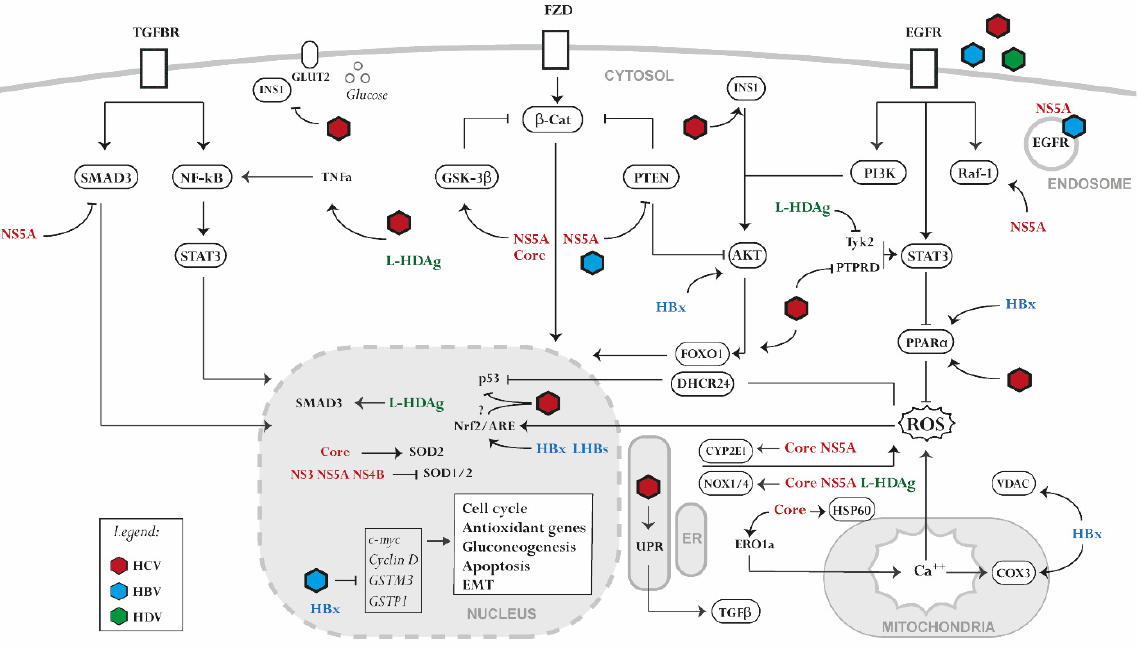
Figure 1. Signaling pathways perturbed by hepatotropic viral proteins. HCV, HBV, and HDV alter liver homeostasis by disrupting several signaling processes associated with (1) the generation of oxidative stress and the dysregulation of the antioxidant system, (2) the alteration of a pro- inflammatory signaling, (3) the hijacking of glucose and lipid metabolism, (4) the dysregulation of host genome expression. NS3, NS4B, NS5A, (non-structural protein 3/4B/5A); HBx, (hepatitis b X antigen); LHBs, (large HBV surface antigen); L-HDAg, (large HDV